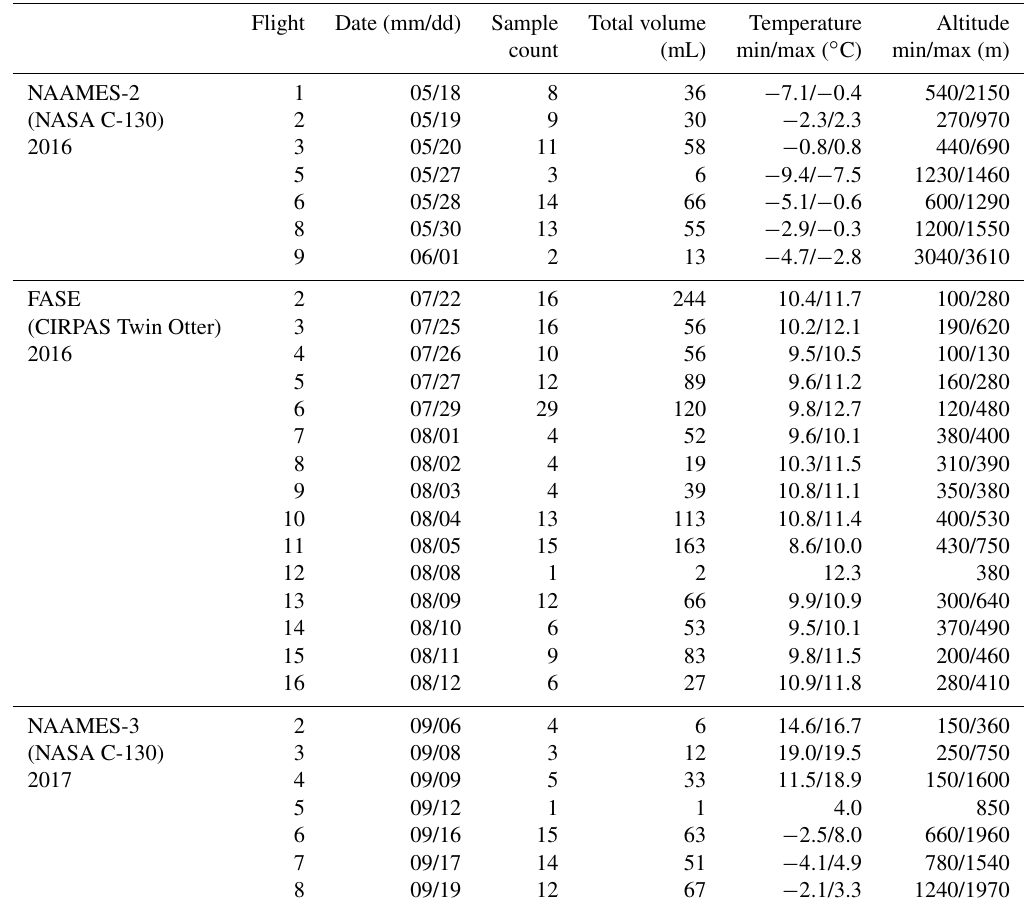
Table 4. Summary of flights and cloud water